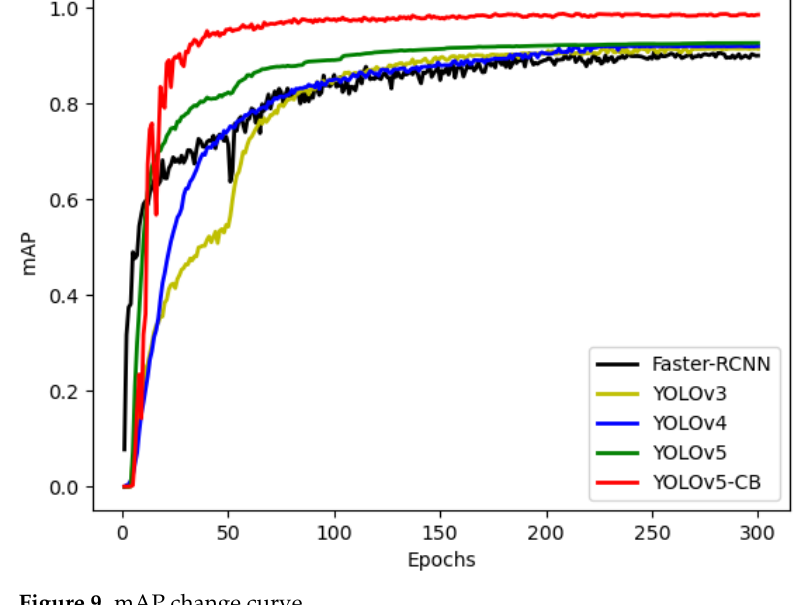
Figure 9. mAP change curve.